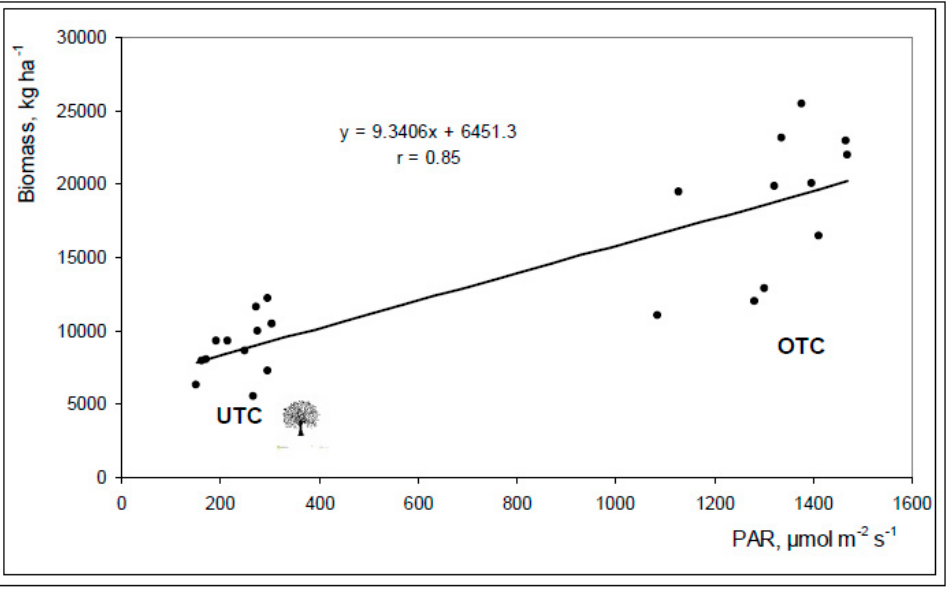
Figure 16. Relationship between photosynthetically active radiation (PAR) measured by ceptometer and pasture biomass productivity in April 2016, in all of the twenty four sampling points (under tree canopy, UTC and outside tree canopy, OTC).